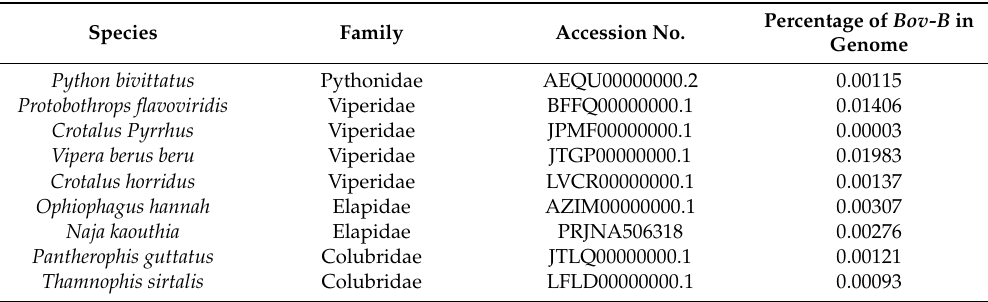
Table 2. Percentage of Bovine-B long interspersed nuclear element (Bov-B LINE) retrotransposon in the snake genome determined using BLASTN. Species Family Accession